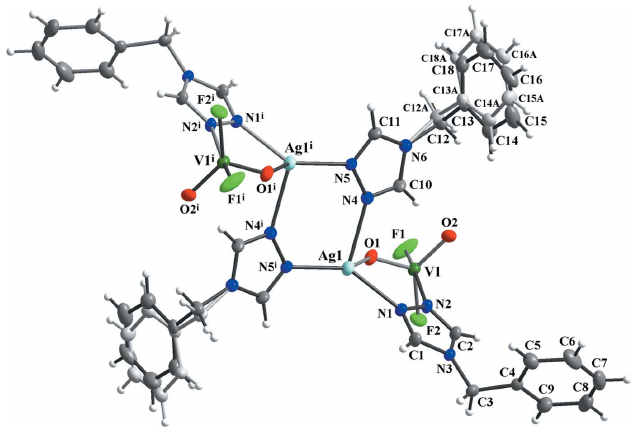
Figure 1 The molecular structure of compound I , showing the atom-labeling scheme [symmetry code: (i) (cid:3) x , (cid:3) y + 1, (cid:3) z ]. Displacement ellipsoids are drawn at the 30% probability level.